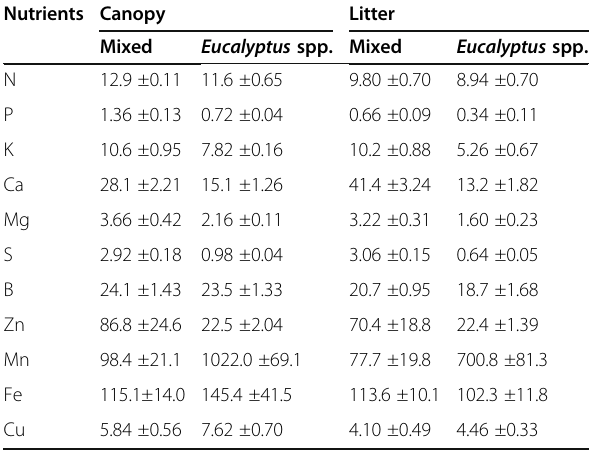
Table 4 Nutritional values of leaves in the canopy and litter.